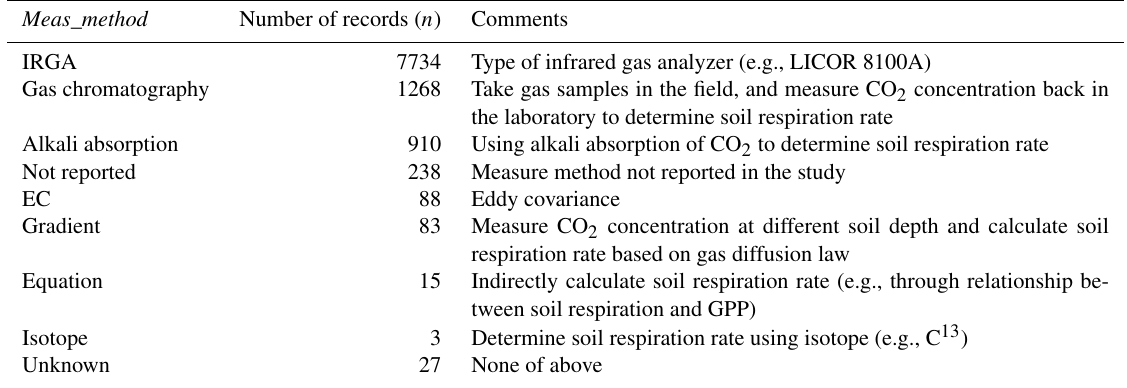
Table 2. Summary of standardized measurement method ( Meas_method ) in SRDB-V5. Meas_method Number of records ( n